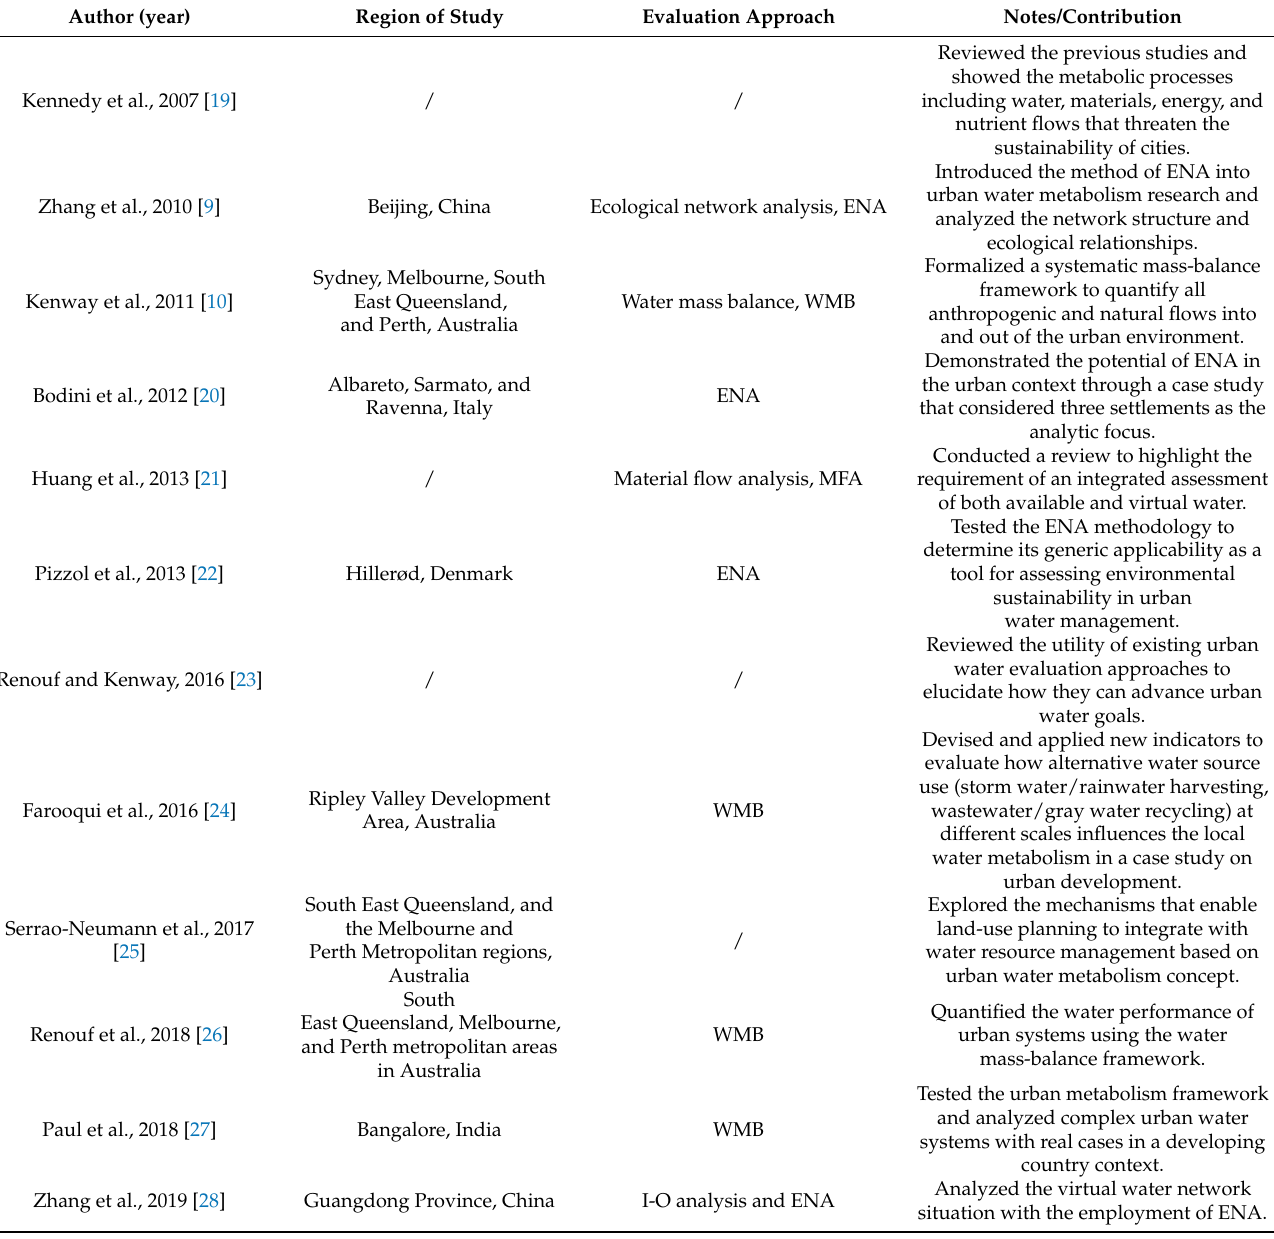
Table 1. Chronological review of recent urban water metabolism